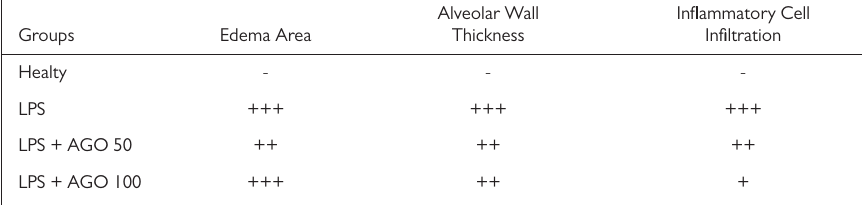
Table 1. Histopathological Scoring